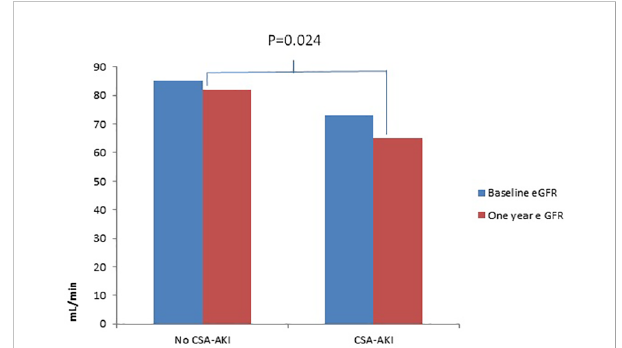
FIGURE 1 Differences in eGFR at 1-year follow-up between patients who had CSA-AKI and those who did not. CSA-AKI, cardio surgery associated acute kidney injury; e GFR, estimated glomerular fi ltration